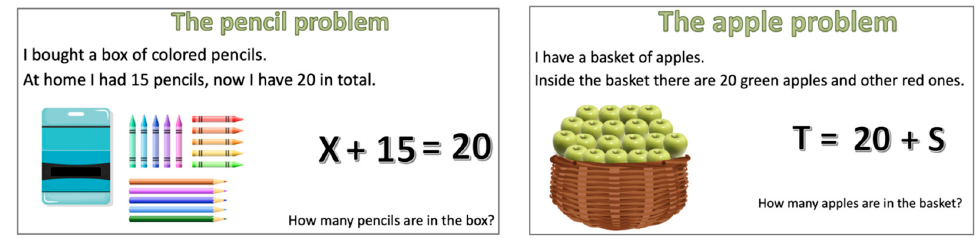
Figure 3. Problem session 6.